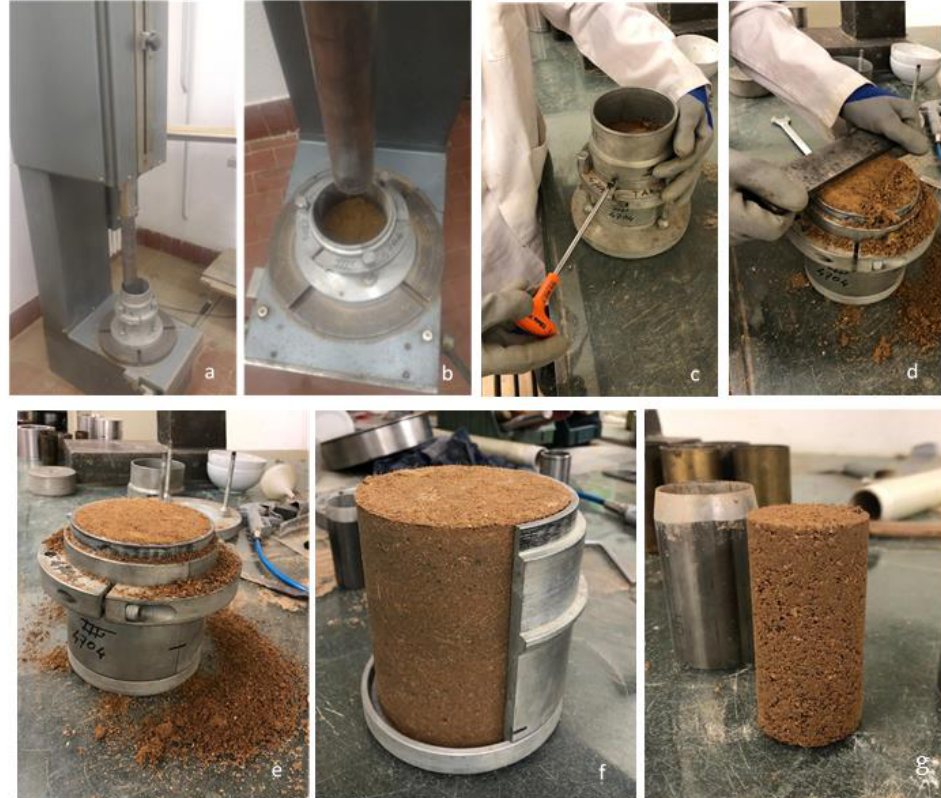
Figure 2. ( a , b ) The Proctor machine, the hammer applies blows to the mold; ( c ) the opening of the mold; ( d ) leveling of the top; ( d , e ) the proctor sample leveled; ( f ) opening the mold ( g ) sample cored after the extraction.